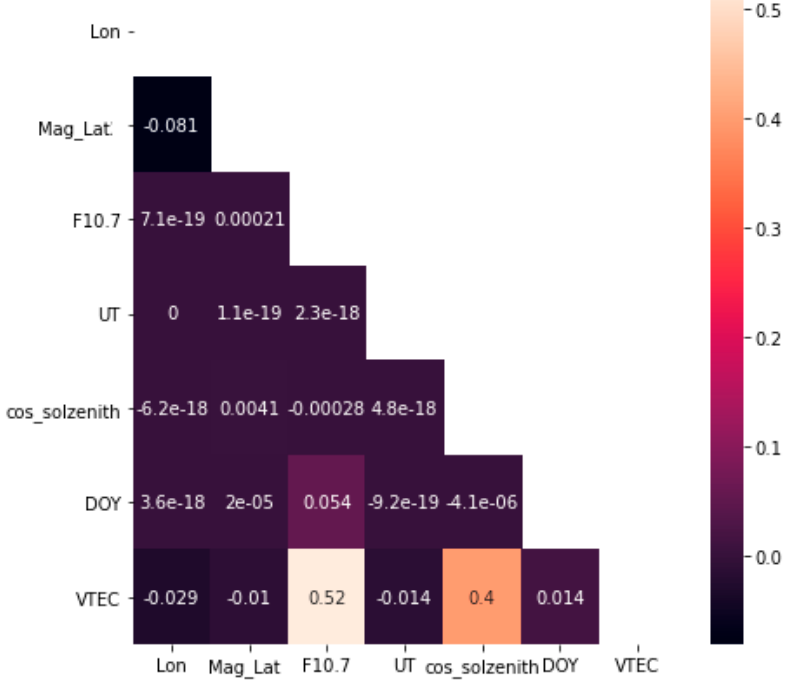
Figure 2. Correlation matrix between the network’s input features.